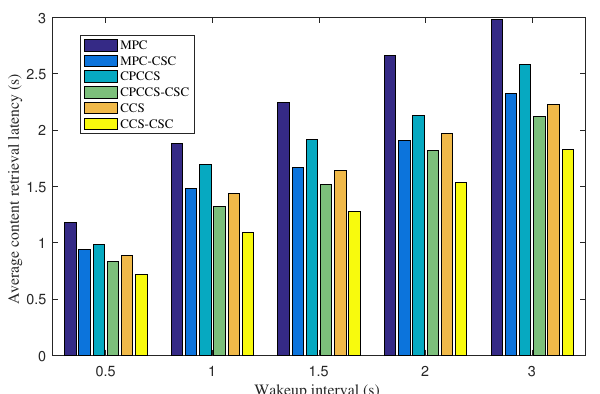
Figure 3. Average content retrieval latency of MPC, MPC-CSC, CPCCS, CPCCS-CSC, CCS, and CCS-CSC under various wakeup